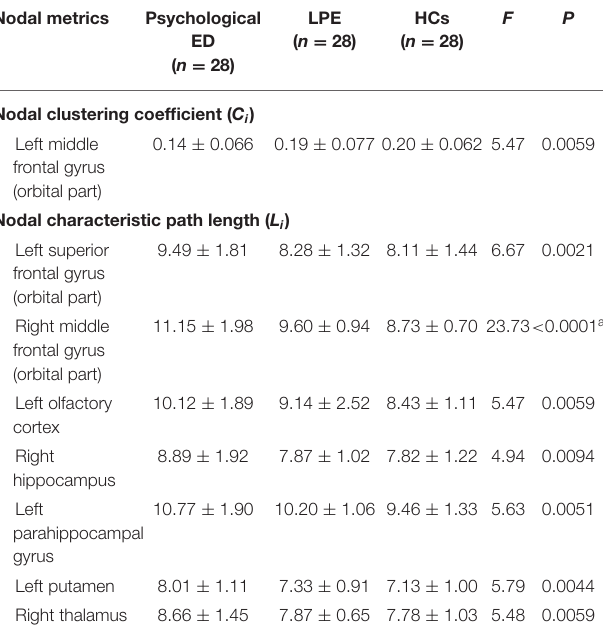
TABLE 3 | Differences of nodal segregative and integrative parameters in the white matter brain networks. Nodal metrics Psychological